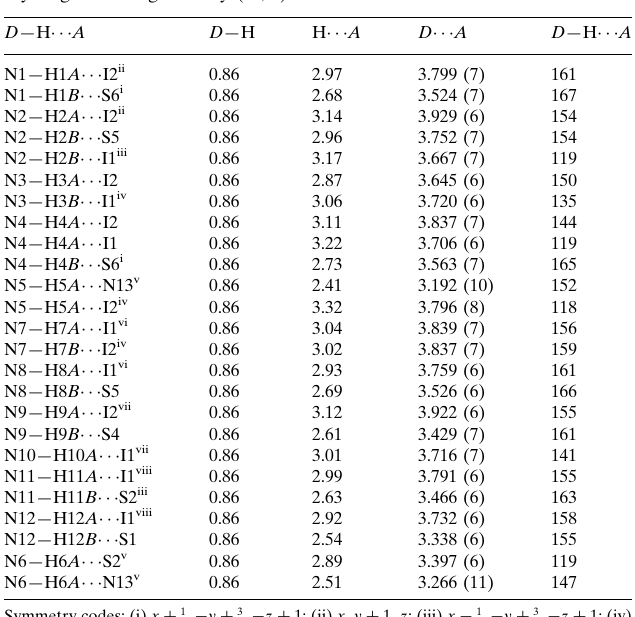
The title complex, {[Cu(CH by the reaction of CuI and thiourea in acetonitrile. There are two independent Cu I ions in the asymmetric unit which are coordinated by two terminal and two bridging thiourea ligands